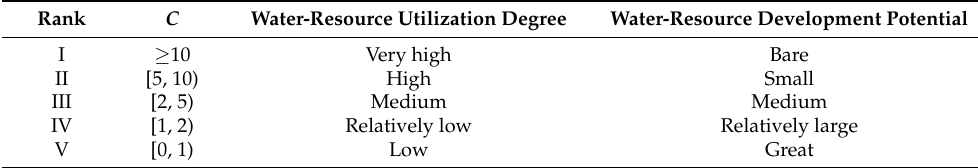
Table 1. Classification and evaluation criteria of water-resource load index [30,31]. Rank C